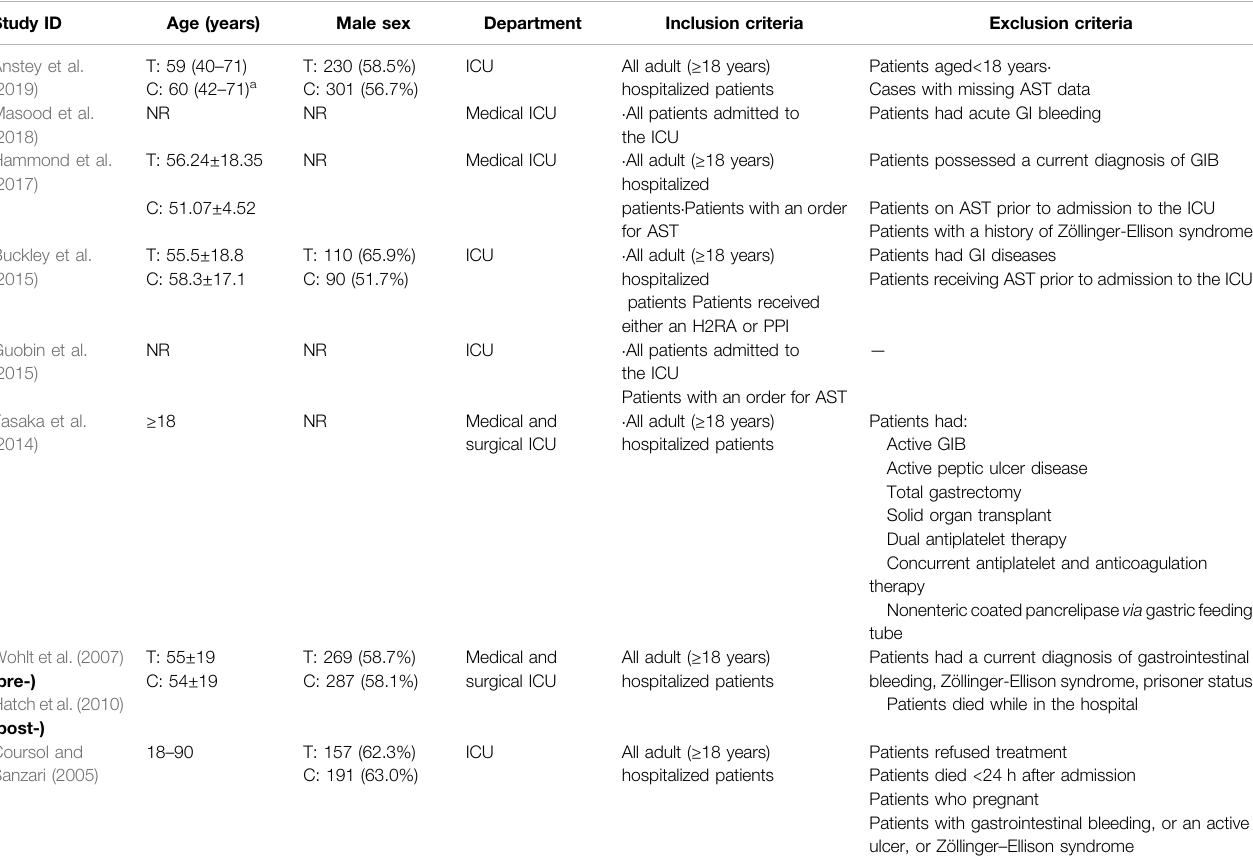
TABLE 2 | Participant characteristics of included studies.* △